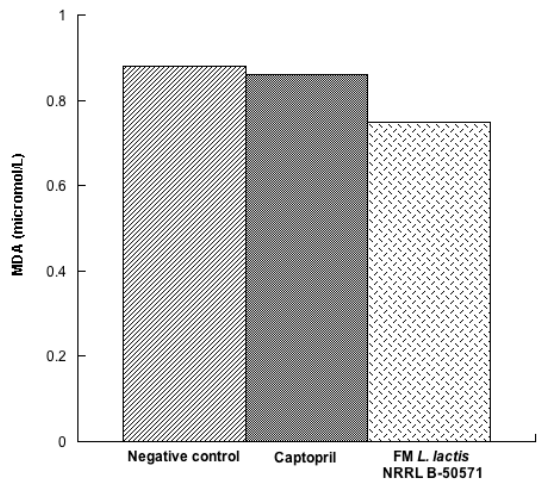
Figure 10. Lipid peroxidation represented as malondialdehyde (MDA) content in plasma from spontaneously hypertensive rats after long-term treatments. Negative control: purified water; Captopril: 40 mg/kg body weight; FM L. lactis NRRL B-50571 (ad libitum): fermented milk with L. lactis NRRL B-50571. Data are presented as median; and were analyzed by non-parametric test (Kruskal–Wallis p < 0.05).